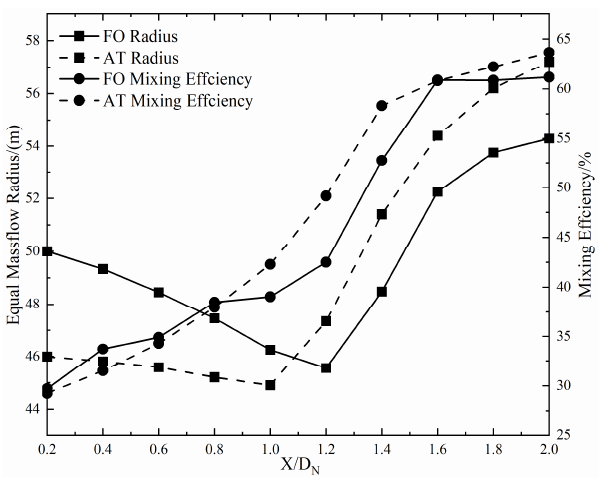
Figure 10. Expansion radius and mixing efficiency of the cross-section with equal mass flow for total pressure = 140 kPa.